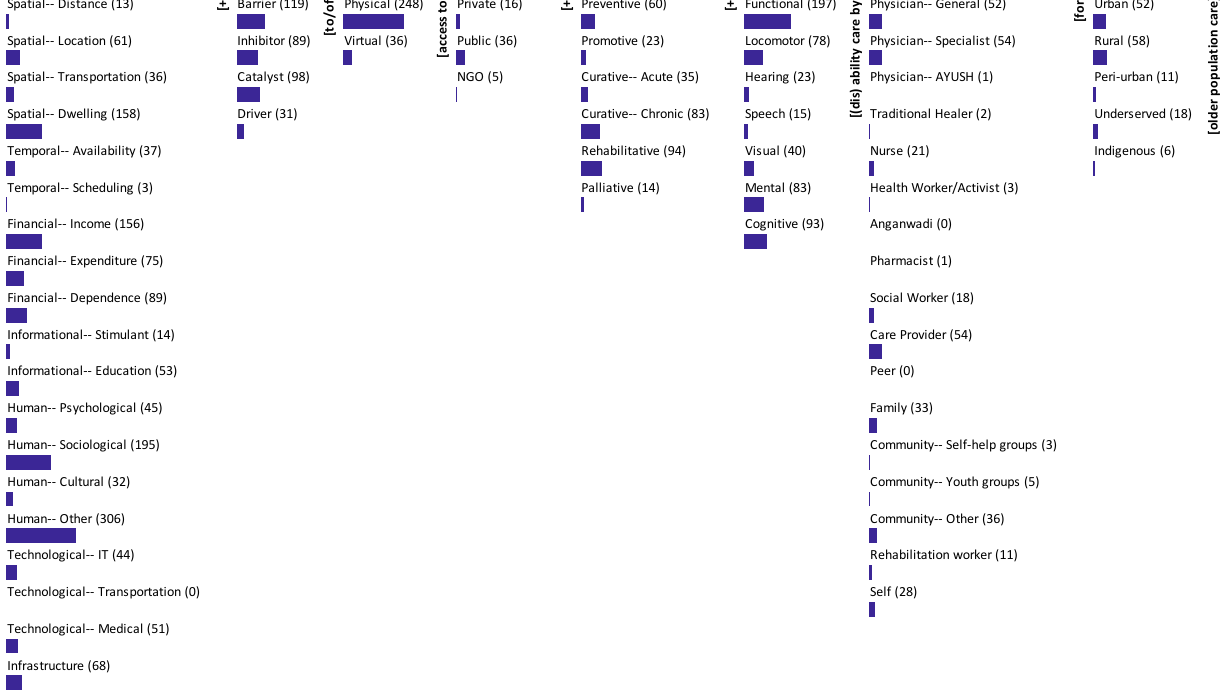
Figure 4. Theme map of access to geriatric disability care. 3.1. Monad Map The monad map in Figure 3 visually and numerically summarizes the frequency of occurrence of each dimension and element of the ontology. It is essentially a histogram (frequency chart) of each dimension and elements of the dimension. The histograms are presented in the order in the ontology.